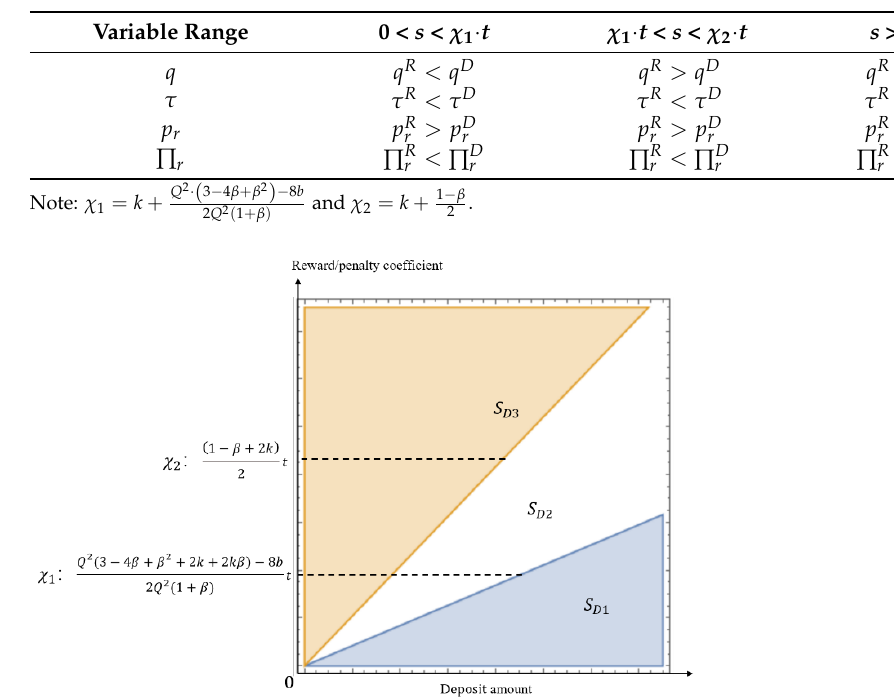
Table 2. Comparison of variables.